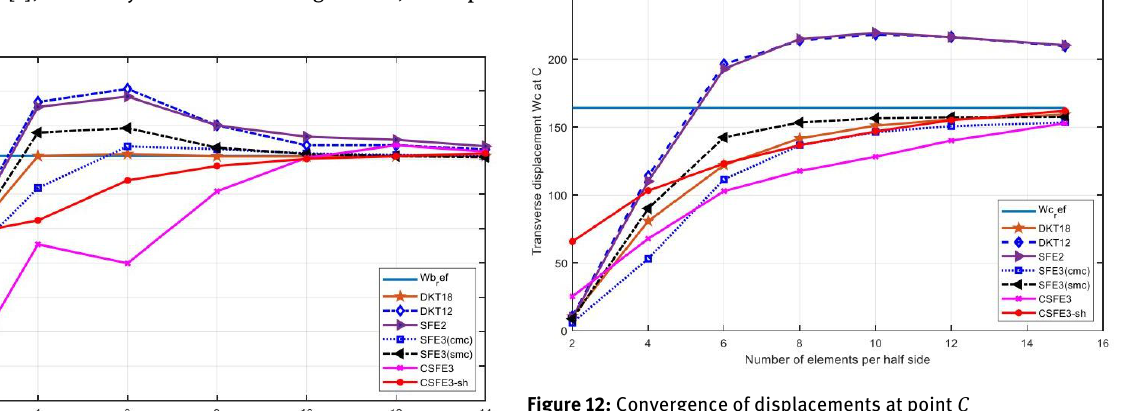
Figure 12: Convergence of displacements at point